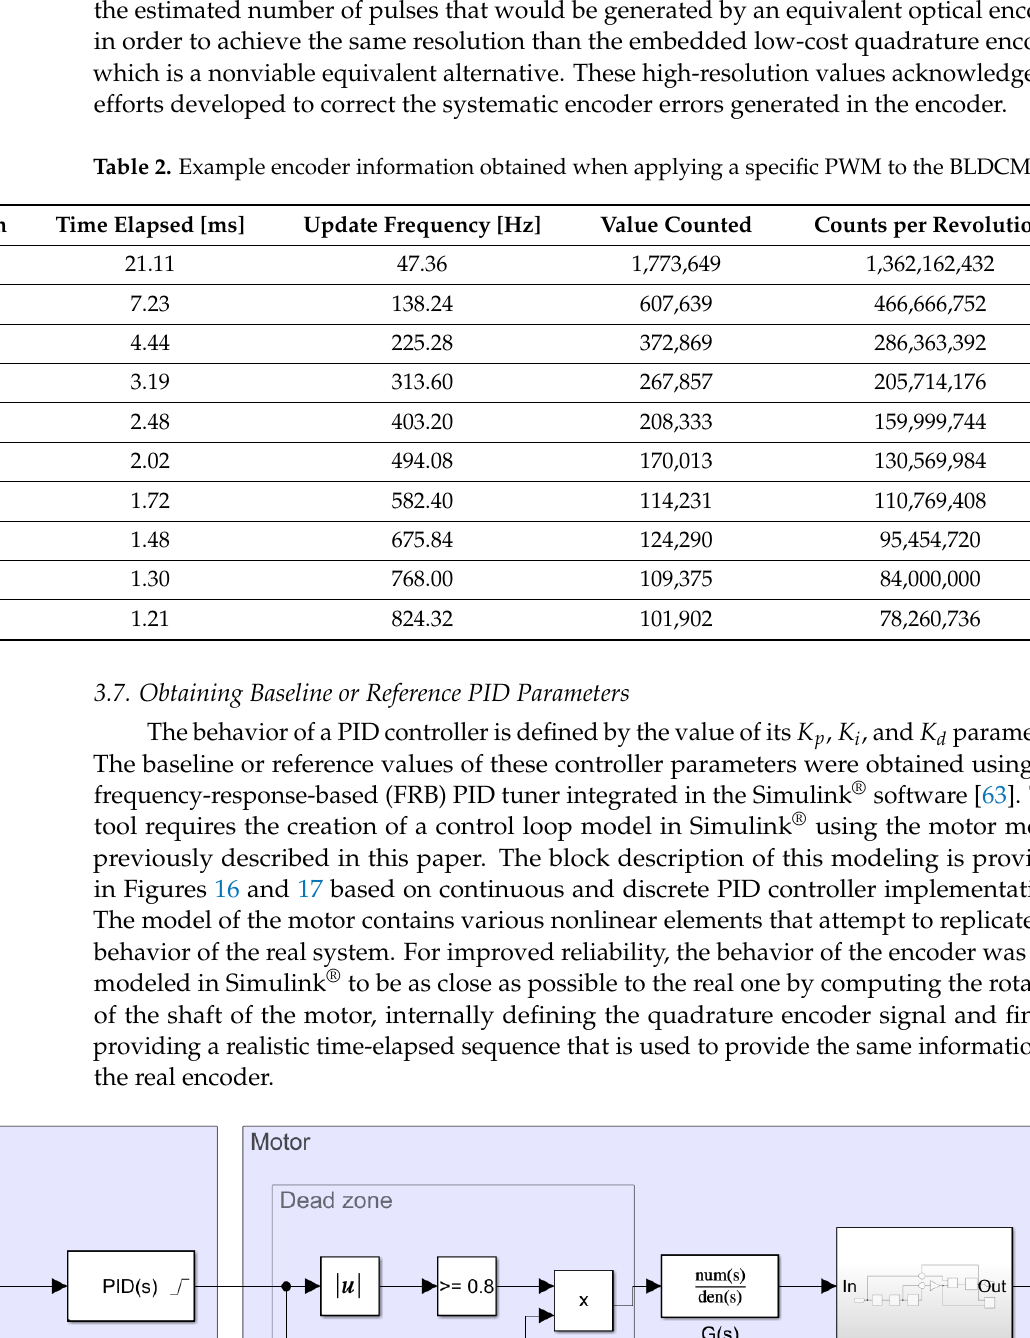
Figure 17. Simulink ® discrete control loop model used by the FRB PID tuner. 3.8. Basic Validation of the Baseline or Reference PID Parameters Figure 18 shows a comparison between the real motor behavior (angular rotational velocity measured with the magnetic encoder) and the simulated behavior using a PID closed-loop control, with the baseline PID parameters obtained previously from the FRB PID tuner. Figure 18 shows the responses to the control steps with target speeds of 5, 10, 20, 40, and 60 rpm. On one hand, Figure 18 shows that the real implementation of the PID controller has difficulty when controlling the real DC motor at very low speeds (under 10 rpm). On the other hand, Figure 18 shows that the response of the PID in the cases of target speeds of 20, 40, and 60 rpm can be improved, because there is a peak and a valley undershoot during the acceleration of the mobile robot. This peak – valley response is not present in the simulation data and only appears in the real experimentation data provided by the magnetic encoder. The conclusion of this basic validation is that the baseline PID parameters obtained from the FRB PID tuner function applied to control this real DC motor that provides feedback using a low-cost magnetic encoder will require additional optimization in order to improve the response of the driving motors used in the APR-02 mobile robot, because a robotic application is a very demanding PID application that requires the minimum overshoot and undershoot in order to follow the planned trajectory ensuring the minimum possible structural error.